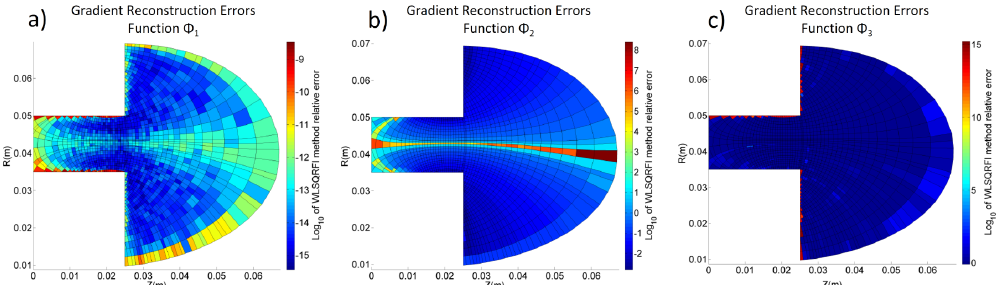
Figure 11. Gradient reconstruction (GR) errors for various functions: log10 of relative errors in the WLSQR method -9 stencil points, inverse-distance weighting for ( a ) φ 1 ∼ λ 2 + σ 2 ; ( b ) φ 2 ∼ λ 3 × σ 3 ; ( c ) φ 3 ∼ sin λ × cos σ (elements are colored according to the worst GR error for their respective